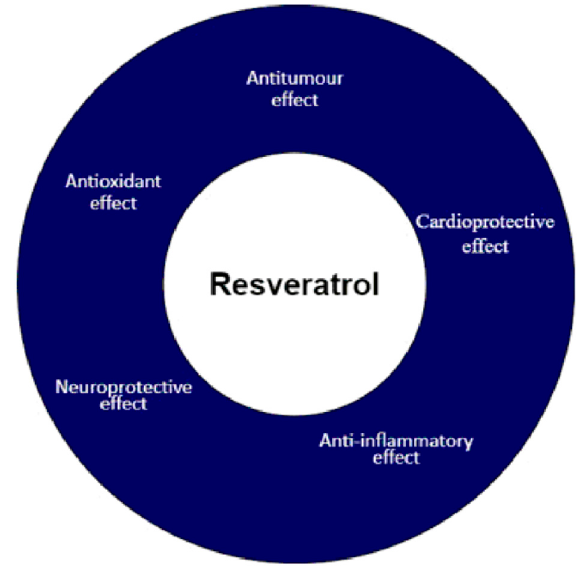
Figure 3. Potential clinical properties of resveratrol.